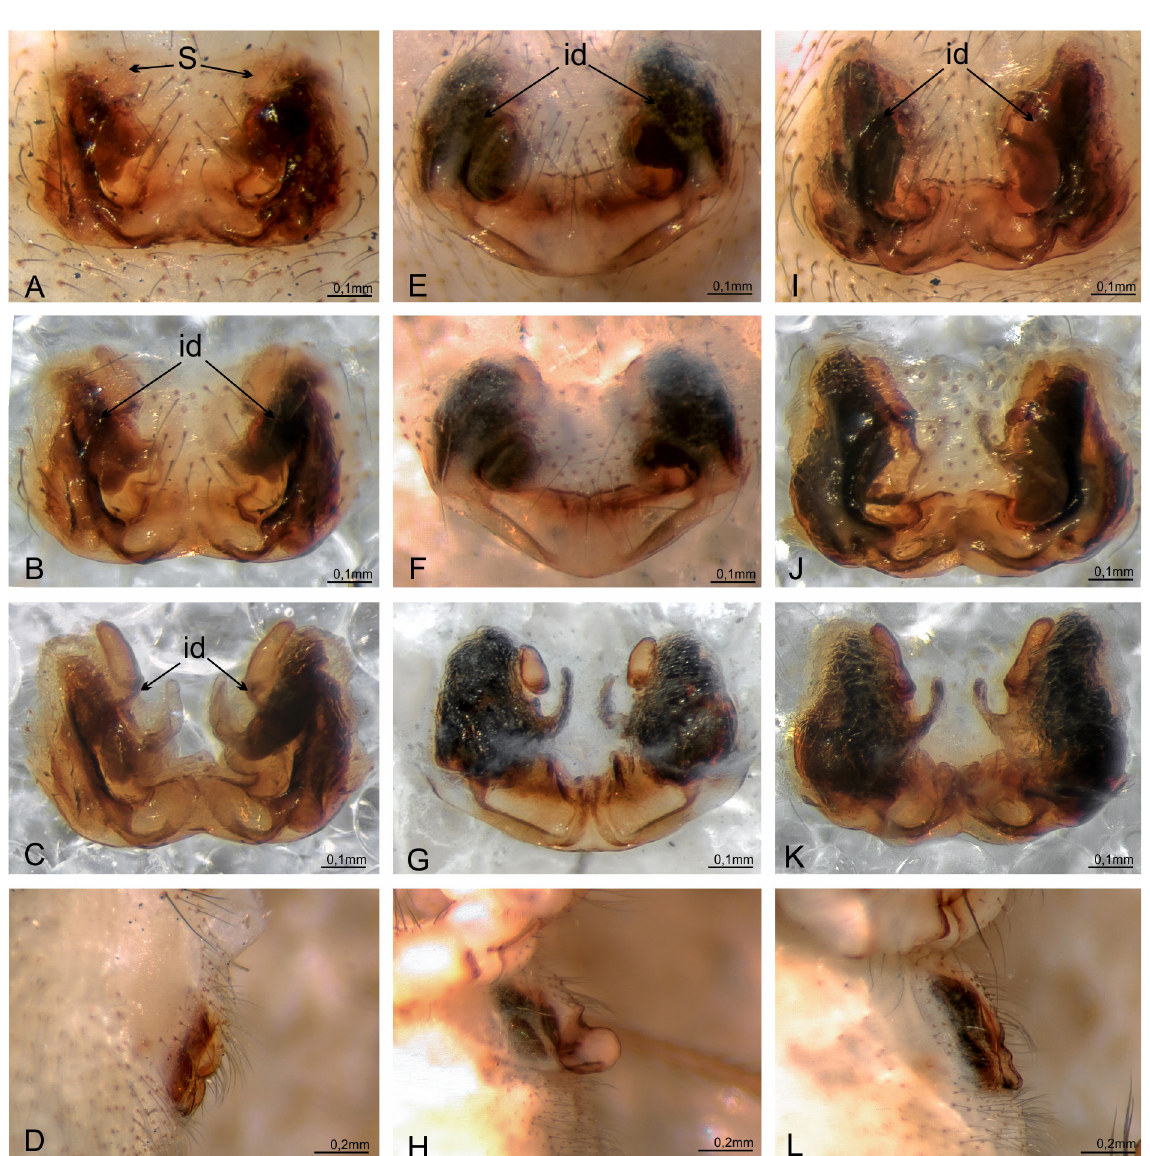
Fig 5. Epigyne and vulva. A–D . Kryptonesticus deelemanae gen. et sp. nov. E–H . K. fagei (Kratochvíl, 1933). I–L . K. arenstorffi (Kulczyński, 1914). A , E , I . Epigyne in ventral view. B , F , J . Epigyne in ventral view after detachment from the opisthosoma. C , G , K . Vulva after treatment with 30% KOH. D , H , L . Epigyne in lateral